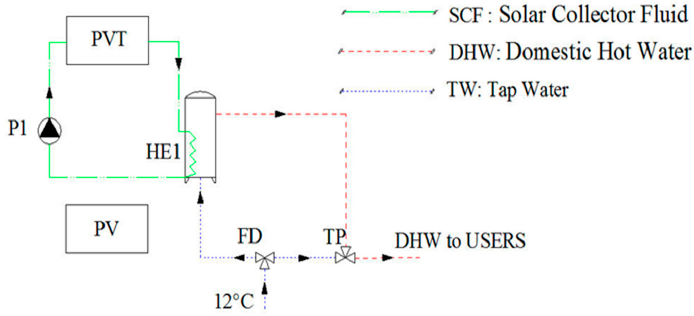
Figure 1. Plant layout. Use same font size in legends labels.